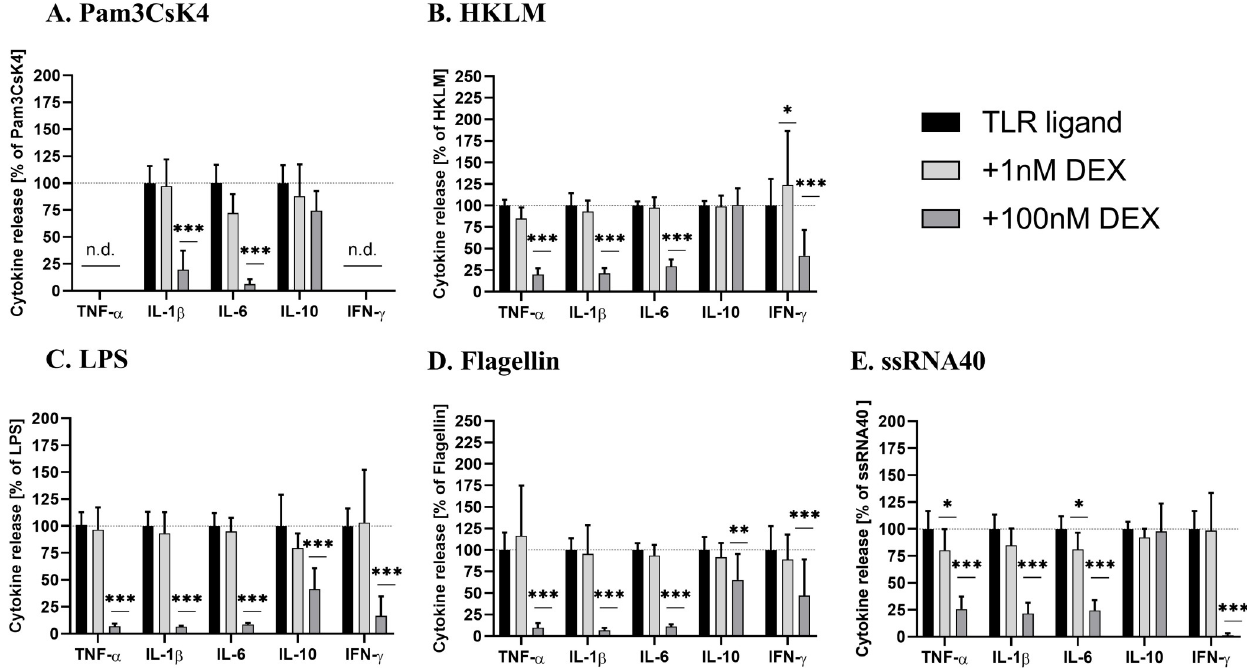
Fig 2. Concentration-dependent cytokine release inhibition through Dexamethason (DEX) in TLR-ligand stimulated WB. Citrate- anticoagulated blood was incubated with Dexamethason or vehicle 6h before stimulation with Pam3CsK4, HKLM, LPS, Flagellin or ssRNA40. The cytokine production by cells stimulated without Dexamethason (vehicle) was set as 100%. Data represent mean ± SD of four experiments performed in duplicate. Differences were significant at p < 0.05 ( � ), p < 0.01 ( �� ) or p < 0.001 ( ��� ) as indicated, compared to WB incubated without Dexamethason. The concentrations of TNF- α and IFN- γ upon Pam3CsK4 stimulation were below detection limit. n.d.—not detectable.